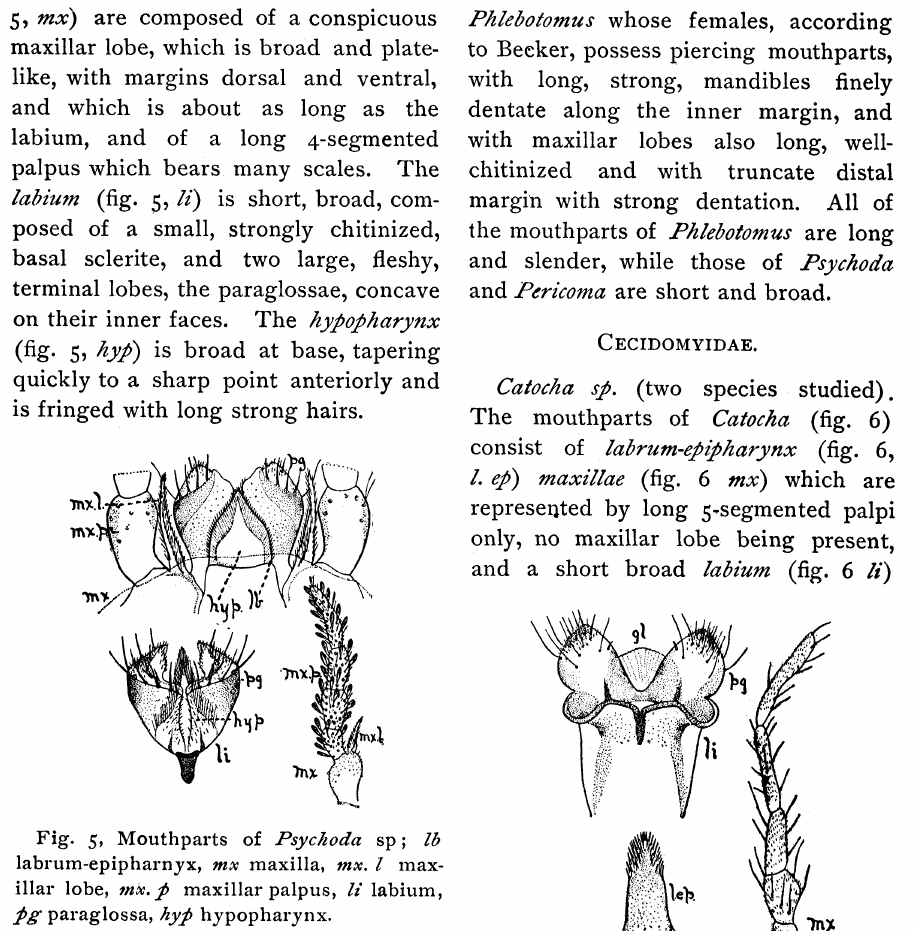
Fig. 5, Mouthparts of Psyckoda sp; lb labrum-epipharnyx, mx maxilla, rex. max- illar lobe, mx. 3 maxillar palpus, li labium,